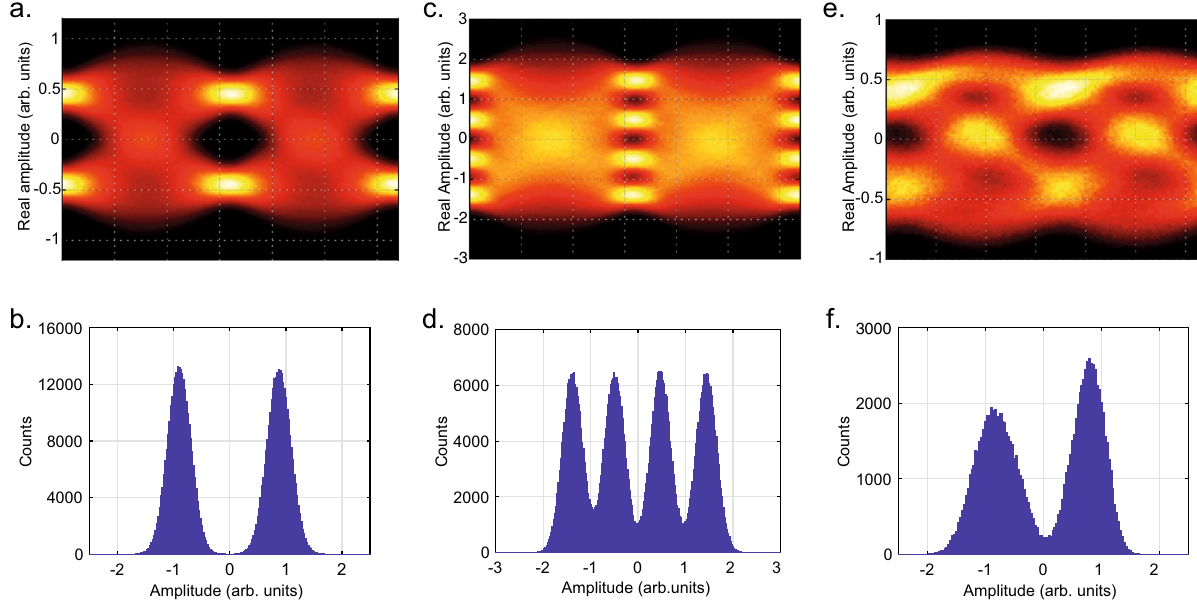
Fig. 6 Detection of an optical data stream at 60 GBaud and 105 GBaud. Eye diagrams collected for a 60 GBaud NRZ OOK ( a ), 60 GBaud PAM4 ( c ), and 105 GBaud NRZ OOK ( e ) data stream at the input of the detector. Histograms of the signal amplitude collected at the optimum sampling point for a 60 GBaud NRZ OOK ( b ), 60 GBaud PAM4 ( d ), and 105 GBaud NRZ OOK ( f ) data stream at the input of the